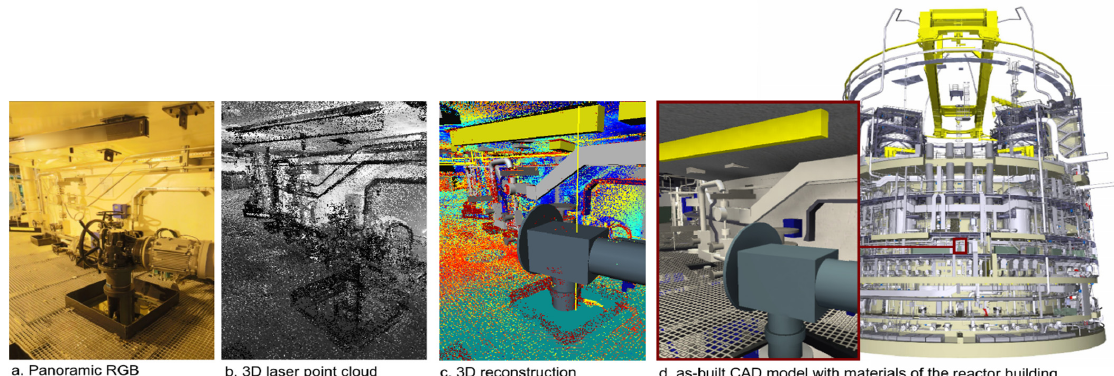
Figure 10. The dense data sources used for as-built reconstruction of the nuclear reactor building from point clouds: ( a ) 1025 panoramic images with 450 million of pixels; ( b ) 1085 laser scans with 40 million 3D points; ( c ) 3D reconstruction of 25 types of objects with specific rules (fitting tolerances and naming encodings) and ( d ) as-built CAD model with 100 rooms and 100,000 3D objects.